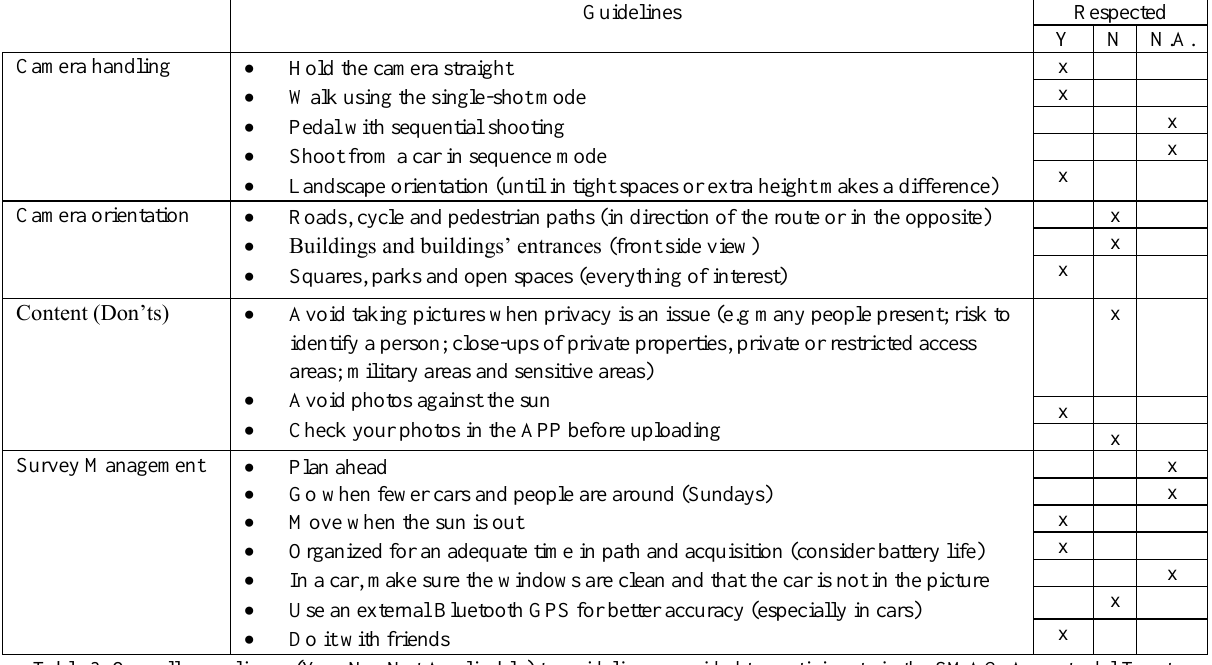
Table 3. Overall compliance (Yes, No, Not Applicable) to guidelines provided to participants in the SMAC, Arquata del